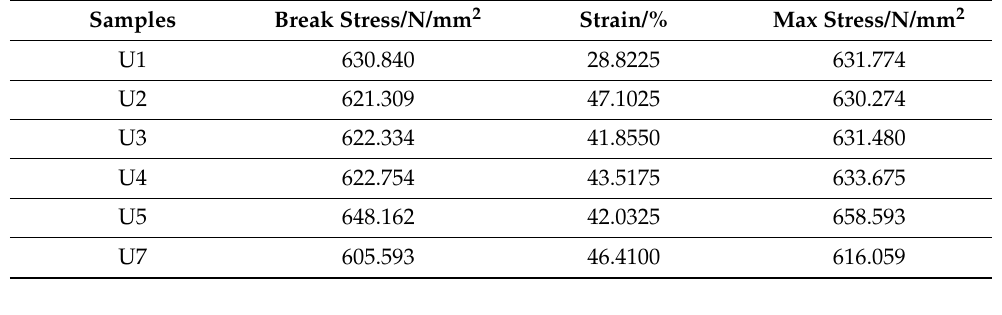
Table 6. Results of tensile test.